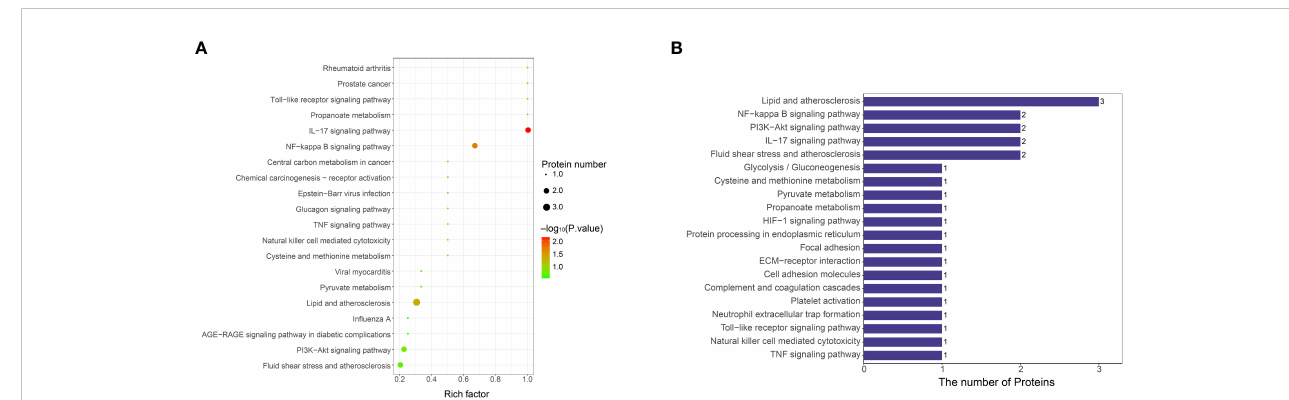
FIGURE 6 KEGG functional enrichment analysis of differentially expressed protein signaling pathways. (A) Bubble chart of signaling pathways associated with differentially expressed protein. The ordinate represents the statistical results of differential proteins under each KEGG pathway, the bubble color represents the signi fi cance of the enriched KEGG pathway, the P value is calculated based on Fisher ’ s exact test, and the color gradient represents the size of the P value (-log10), the closer the color is to red, the smaller the P value, and the higher the signi fi cance level of the corresponding metabolic pathway enrichment. (B) KEGG pathway annotation statistics for differentially expressed proteins. The ordinate is the name of the pathway involving differentially expressed proteins, and the abscissa represents the number of differentially expressed proteins involved in the pathway.